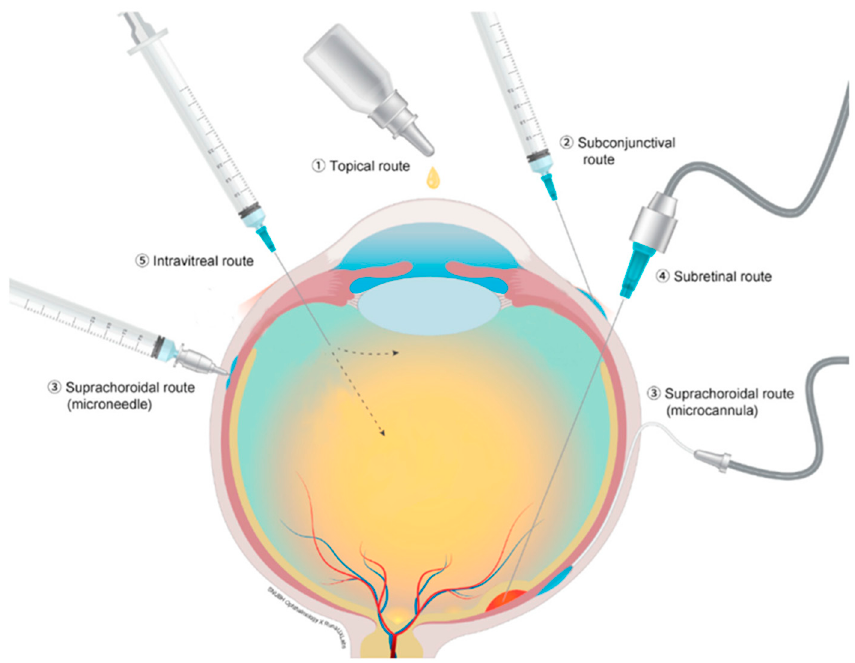
Figure 1. Different ocular drug administration routs; ( 1 ) topical route, ( 2 ) subconjunctival route, ( 3 ) suprachoroidal route with microcannula and microneedle, ( 4 ) subretinal route and ( 5 ) intravitreal injection. Reproduced from [5], CC BY 4.0 license, Published by MDPI 2021.